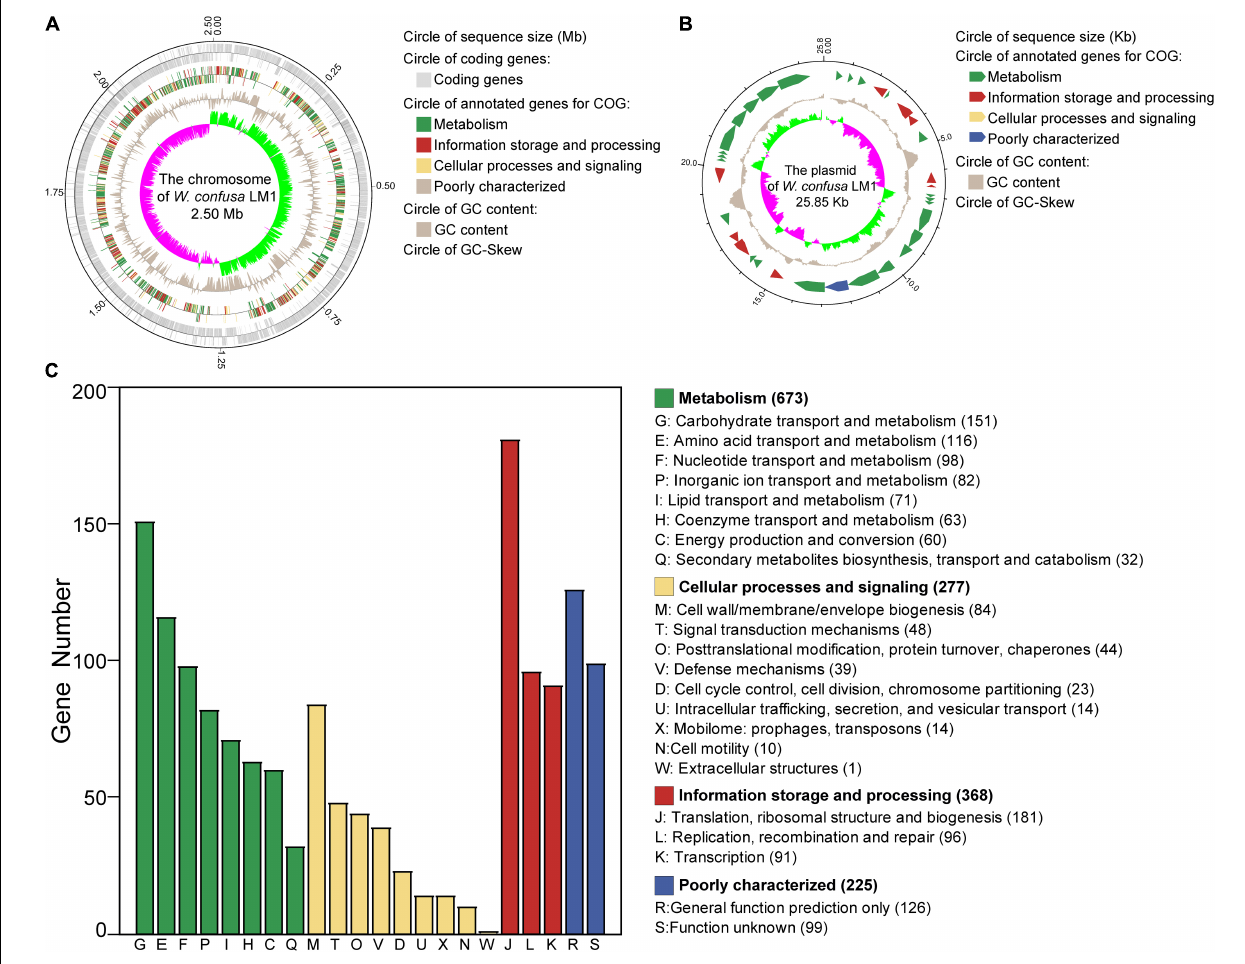
FIGURE 1 | Genome analysis of Weissella confusa LM1. (A) The chromosome features of W. confusa LM1. (B) The plasmid features of W. confusa LM1. (C) Clusters of Orthologous Groups (COG) analysis of W. confusa LM1